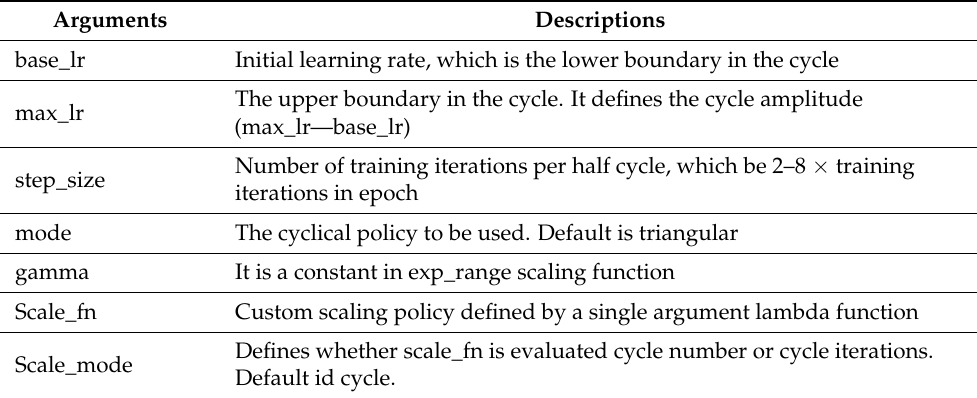
Table 1. The arguments of the CLR algorithm and its descriptions.